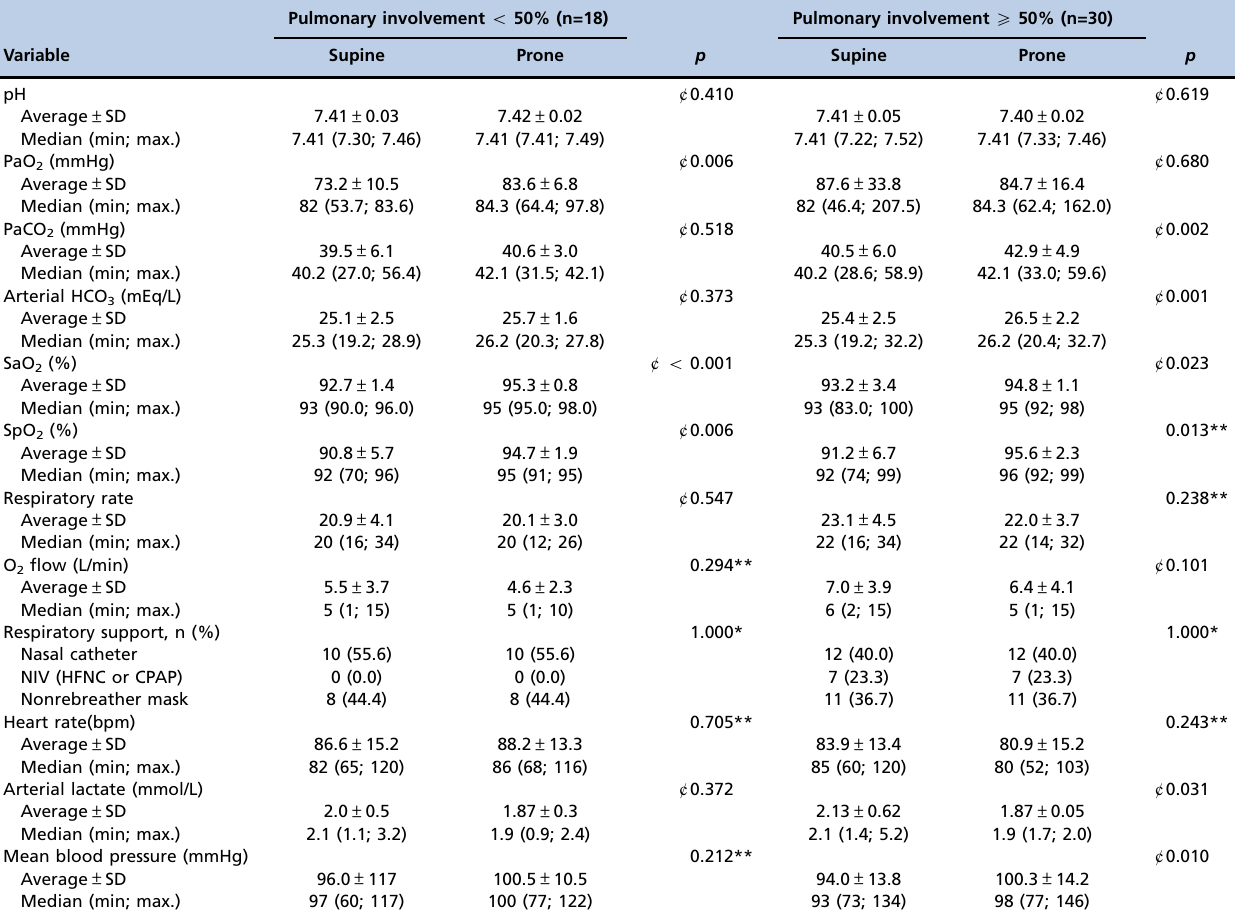
Table 2 - Comparison of patients in supine and prone position in patients with pulmonary involvement p 50% and 4 50% evaluated by computed tomography of chest.